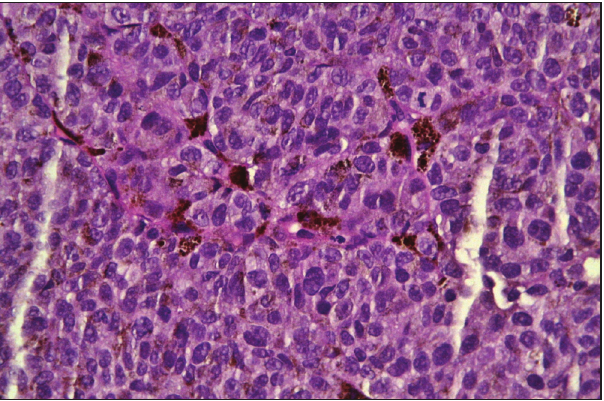
Figure 4) Detail of poorly differentiated cell population with melanophages